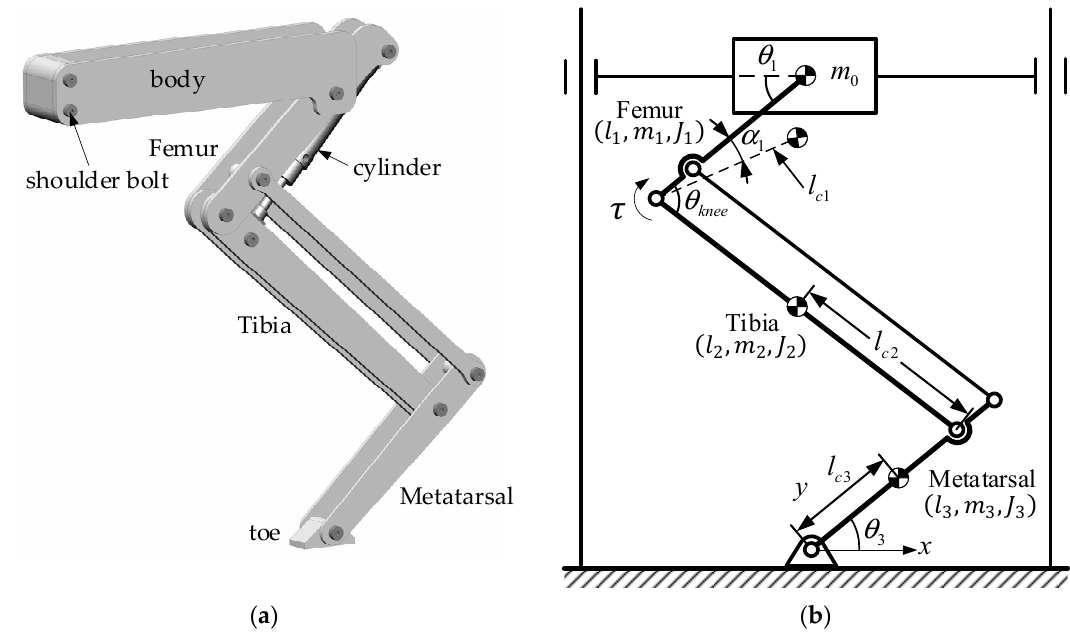
Figure 1. Kangaroo inspired one-legged robot. ( a ) 3D model, ( b ) Sketch of the robot. The centroid of the body is set at the horizontal rack. The centroid positions of the tibia and metatarsal are assumed to be located at the axis of each segment. The